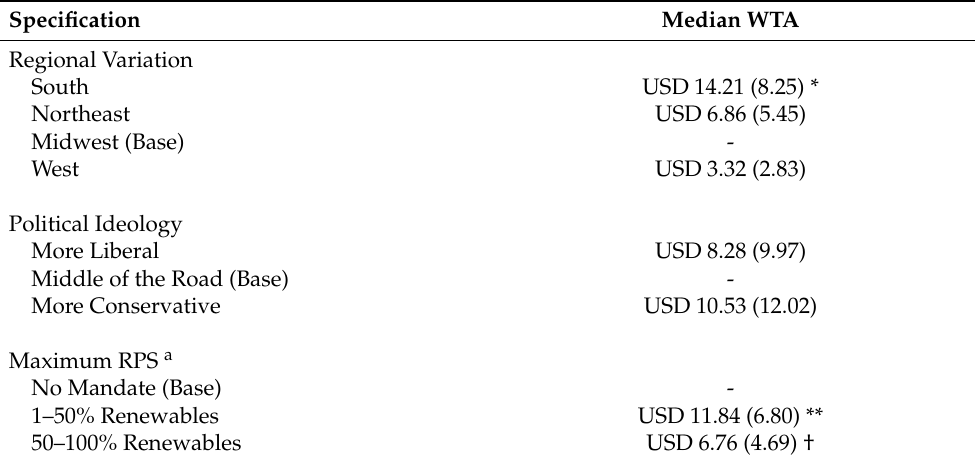
Table 5. Heterogeneity